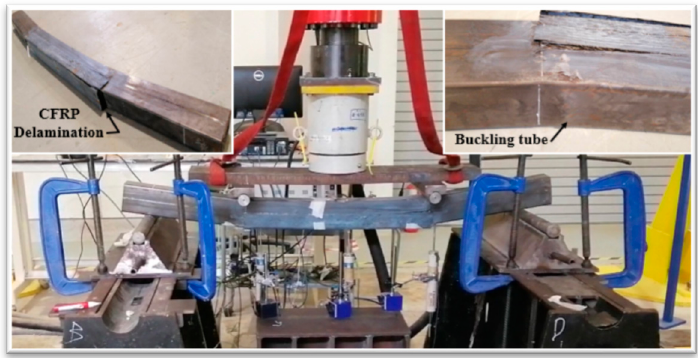
Figure 17. CFRP failure mode of (B-P50-2L) specimen.